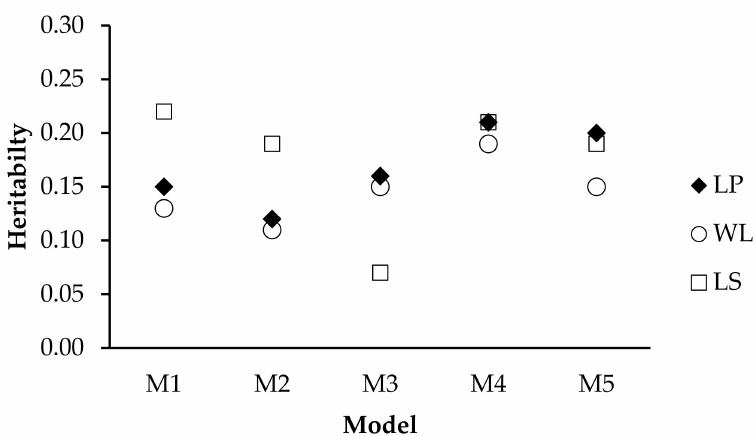
Figure 3. Estimated average heritability for test-day milk yield (TDMY) according to temperature– humidity index (THI) according to model and using Legendre polynomials (LP), linear splines (LS) and Wilmink (WL) in Brazilian Holsteins.